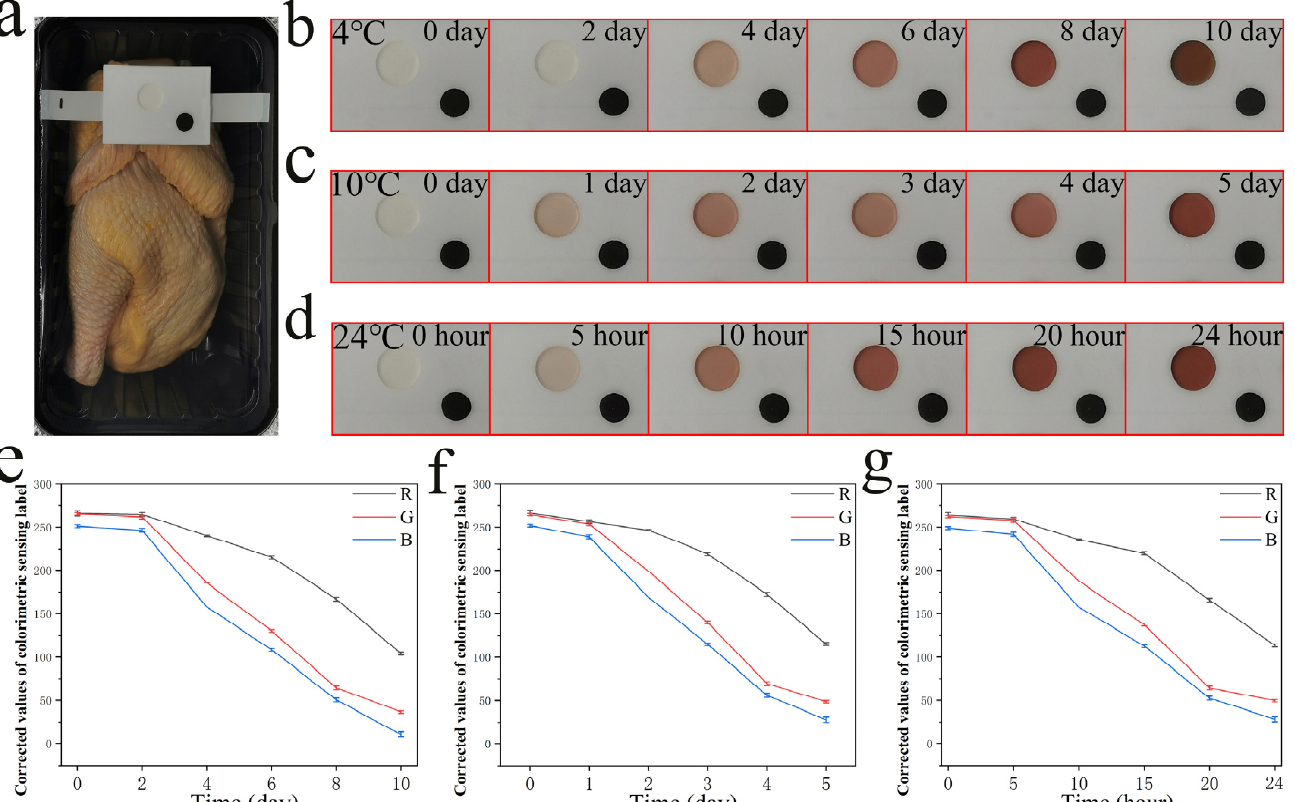
Figure 6. Changes in TVB-N for packaged chilled broiler meat stored at 4 °C.